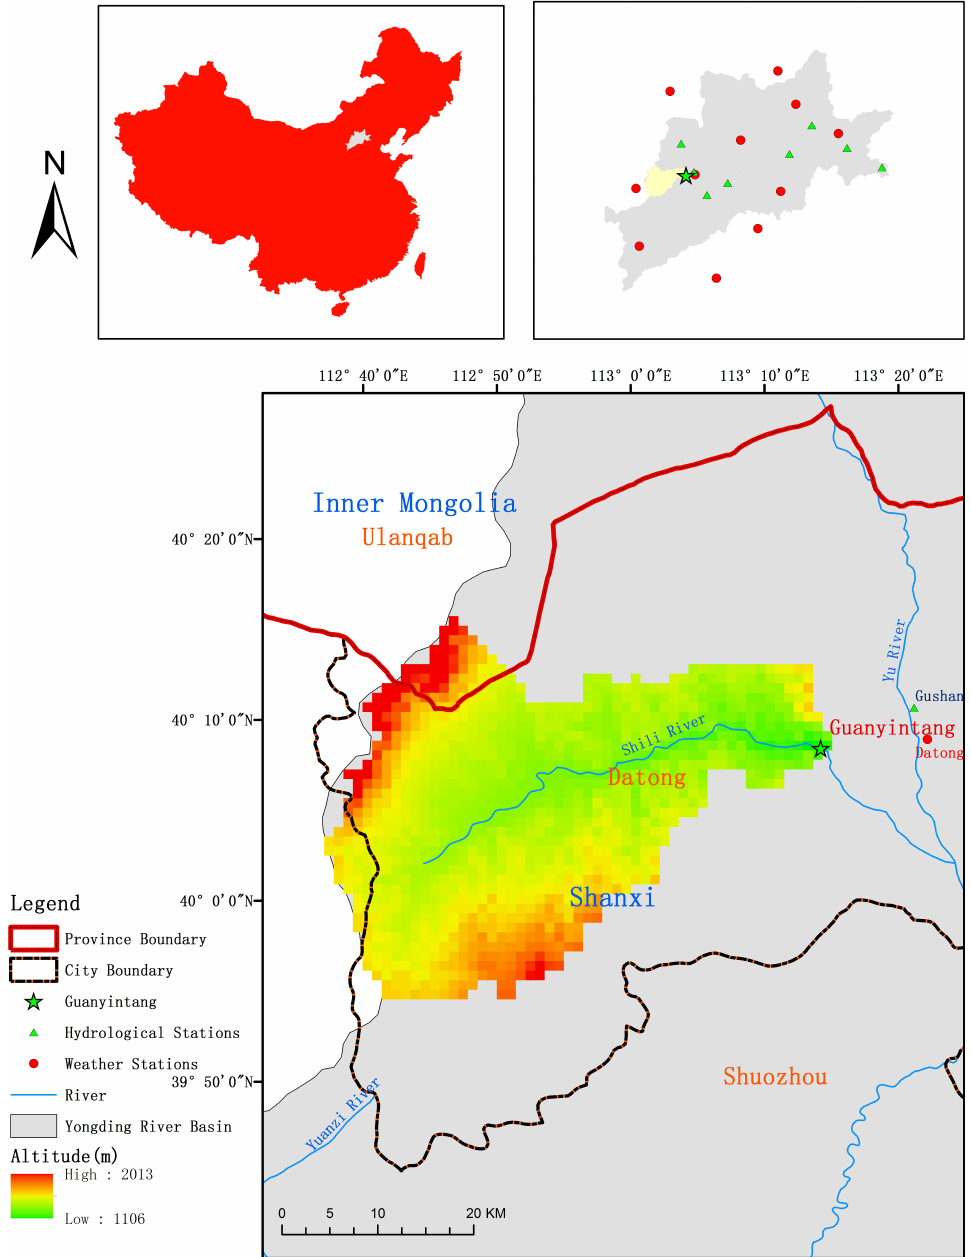
Figure 1. Geographical location of the Guanyintang station and the distribution of meteorological and hydrological